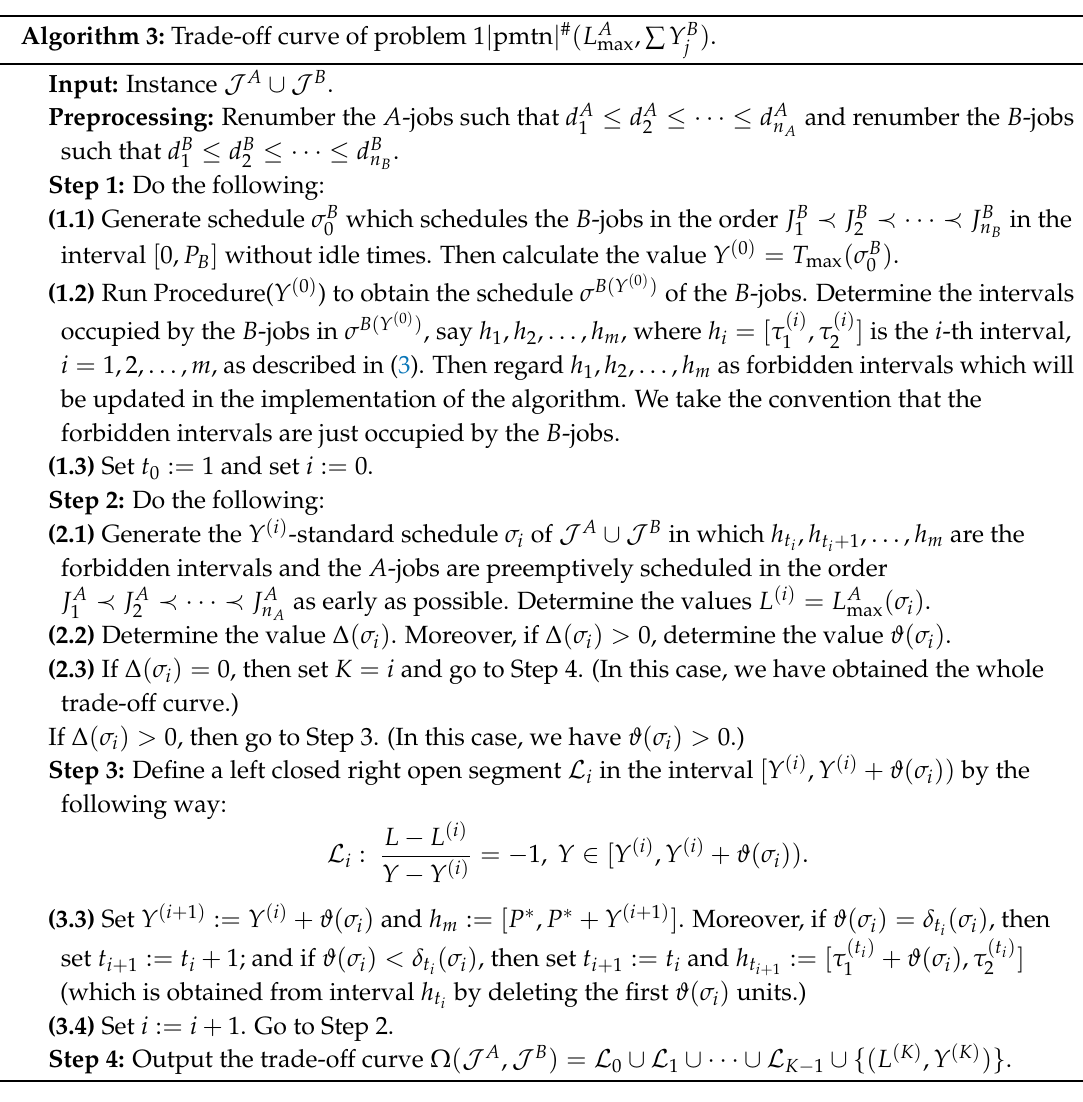
Algorithm 3: Trade-off curve of problem 1 | pmtn | # ( L A